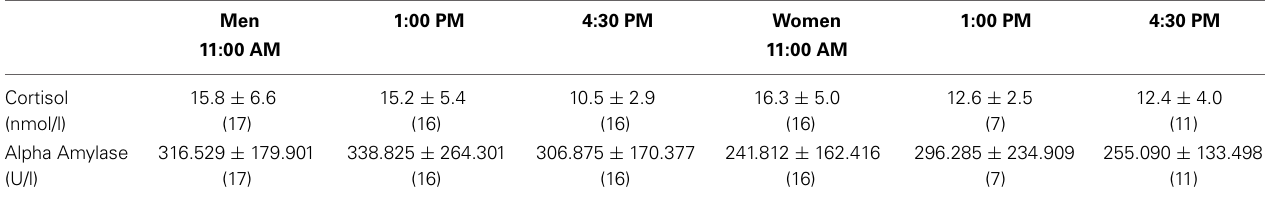
Table 1B | Salivary cortisol and alpha-amylase levels (mean ± SD ) after the CGT in men and women at different time-points during the day; number of subjects is indicated between